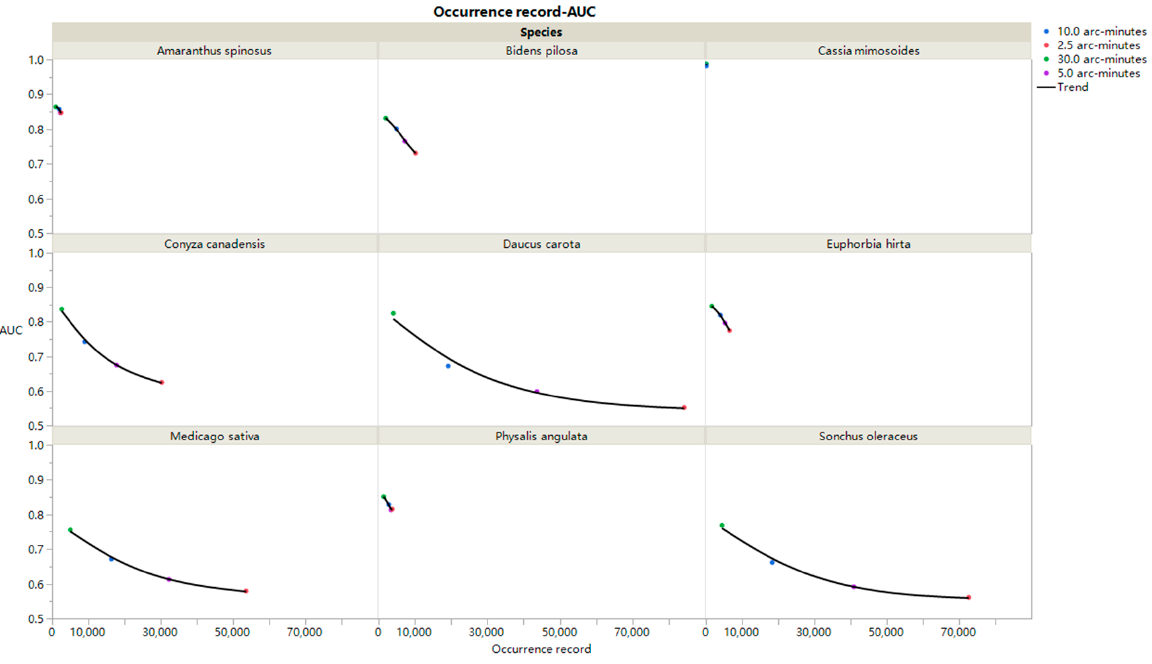
Figure 2. The records and AUC values for nine IAPS. Table 1. The relationships between the potential presence of IAPS-invaded protected areas and the in- equality of IAPS-invaded protected areas; 0.5: 0.5 arcminutes; 2.5: 2.5 arcminutes; 5.0: 5.0 arcminutes; 10.0: 10.0 arcminutes. All the relationships were significant ( p <